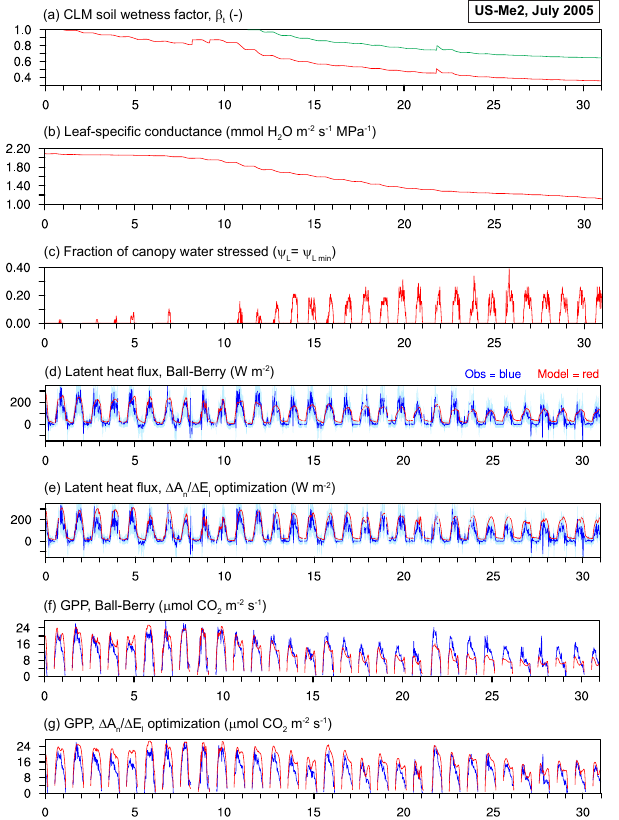
Figure 13. As in Fig. 11, but for July 2005 during an evolving drought.